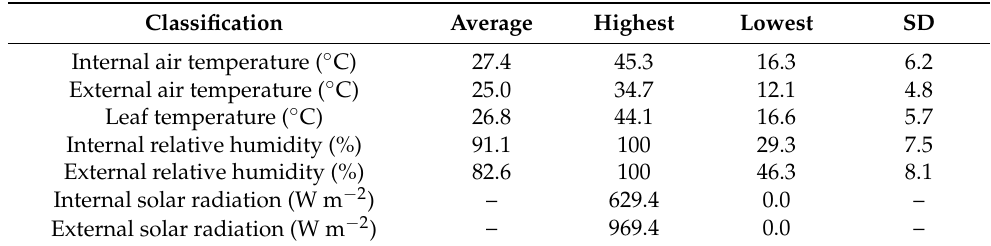
Table 3. Monitoring of micro-climate environment in the greenhouse (from 25 May 2018 to 18 August